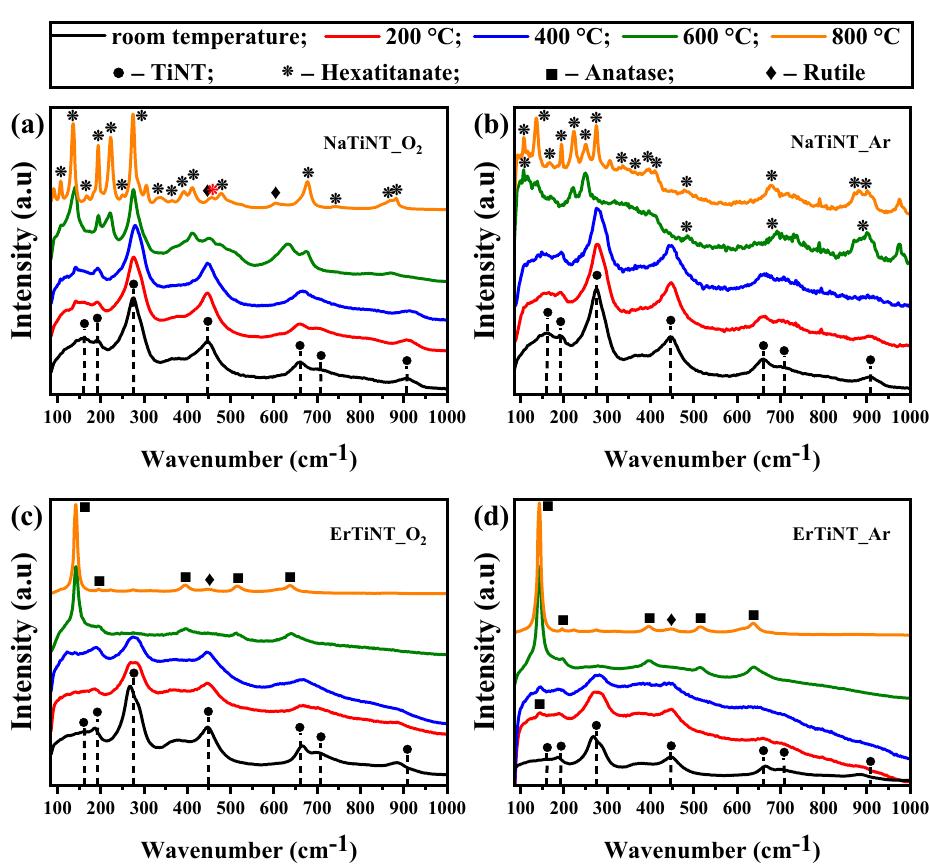
Figure 1. Raman spectra of NaTiNTs and ErTiNTs heat treated in air, Figures ( a ) and ( c ), respectively, and argon (Ar) atmosphere, Figures ( b ) and ( d ), respectively. The dashed lines show the characteristic peaks of the TiNTs, and the symbols indicate the phases observed during thermal treatment at different temperatures. The upper caption is the same for all samples.